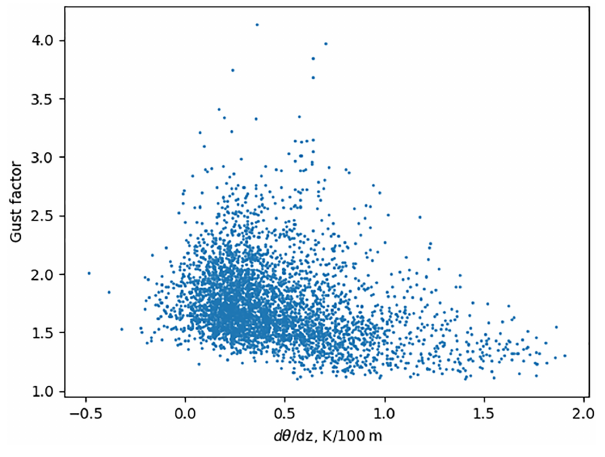
Figure 3. Measured wind gust factor and potential temperature gra- dient in the lowest 100m in Moscow during July